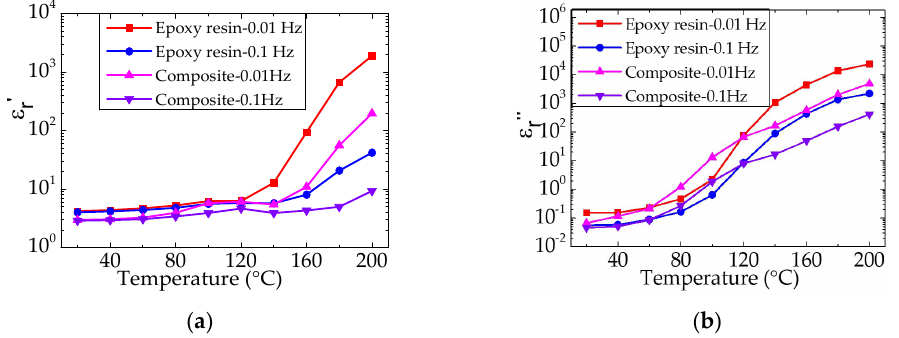
Figure 10. Real part (ε r ′) and imaginary part (ε r ″) of the complex permittivity of epoxy resin ( a ) and its composite ( b ) at different temperatures.